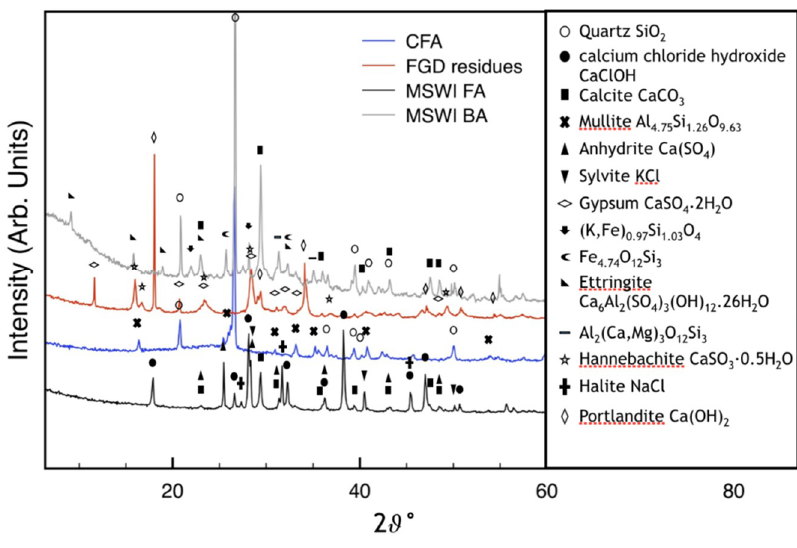
Figure 1. X-ray di ff raction (XRD) patterns of MSWI FA, CFA, FGD residues, and MSWI Figure 1. X-ray diffraction (XRD) patterns of MSWI FA, CFA, FGD residues, and MSWI BA.